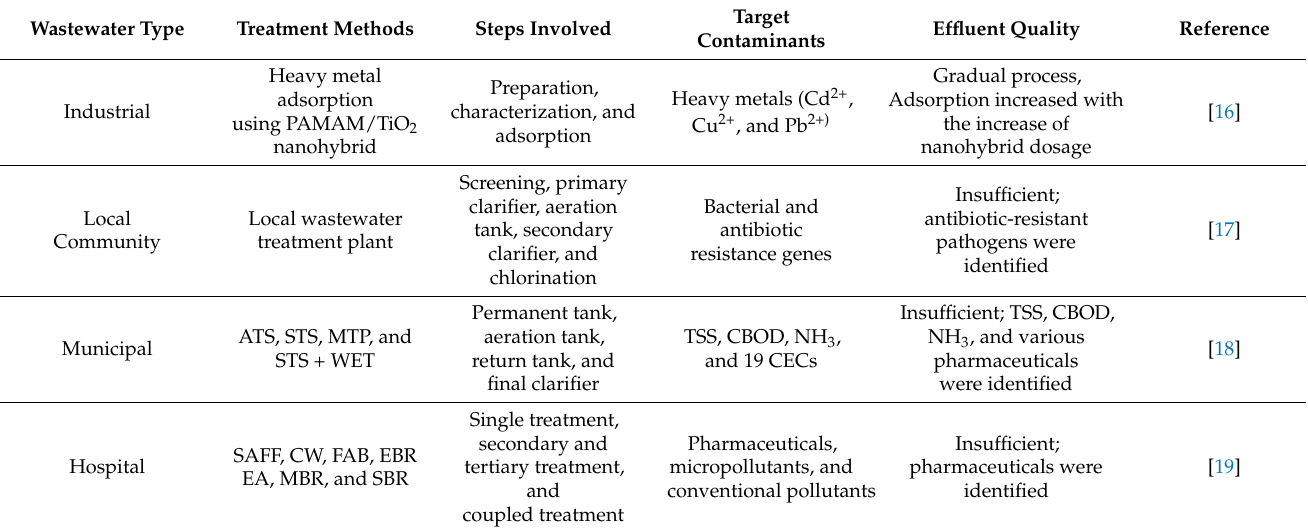
Table 1. Application of conventional treatment technologies in contaminants’ removal from wastewater.